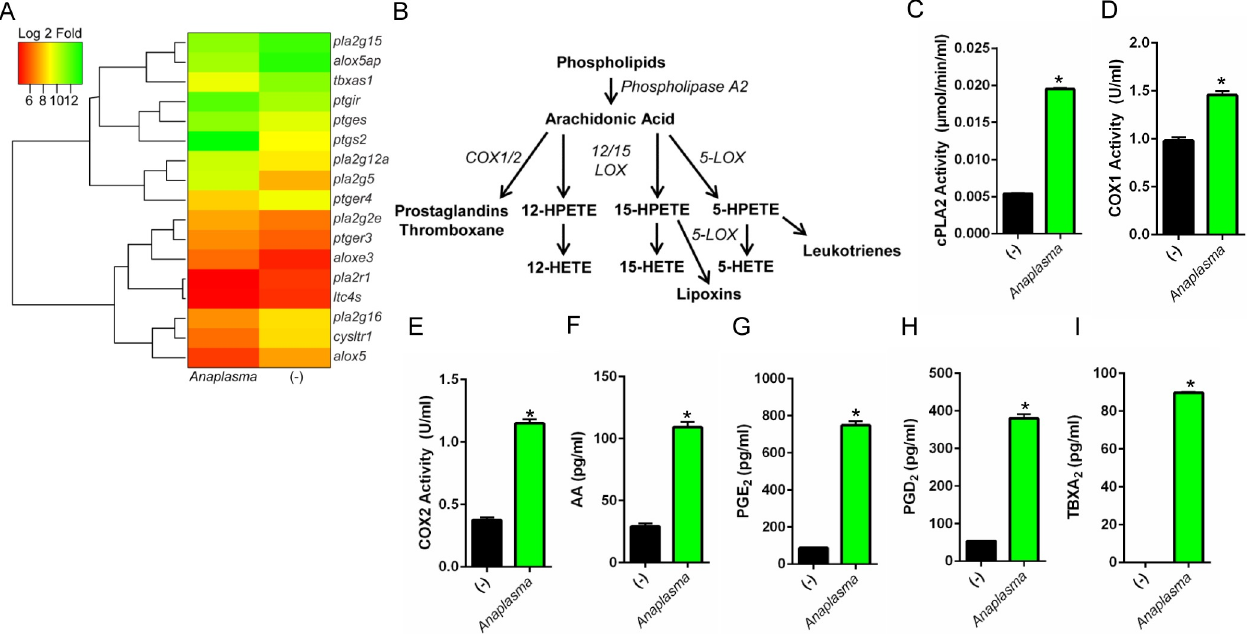
Fig 1. A. phagocytophilum infection induces eicosanoid biosynthesis. (A) Heat map of deep sequencing analysis showing the expression of eicosanoid metabolism genes in murine BMDMs (1.5×10 7 cells) infected with A . phagocytophilum (MOI50) for 18 hours. (B) Schematics of eicosanoid metabolism in murine macrophages. Eicosanoid biosynthesis occurs after the release of arachidonic acid from cell membranes by phospholipase A2 ( e . g ., cPLA 2 ). Arachidonic acid is converted to thromboxane and prostaglandins by cyclooxygenases (COX1/2), whereas 12 ‐ HETE (12 ‐ hydroxyeicosatetraenoic acid), 15 ‐ HETE, 5 ‐ HETE and leukotrienes are synthesized by lipoxygenases (12/15 ‐ LOX and 5-LOX). (C-I) 1.5×10 7 wildtype (WT) BMDMs were stimulated with A . phagocytophilum (MOI25) overnight. Cells were scraped followed by sonication. Enzymatic activities of (C) cPLA 2 , (D) COX1 and (E) COX2 were measured. Levels of (F) arachidonic acid (AA), (G) PGE 2 , (H) PGD 2 , and (I) TBXA 2 in the supernatants of WT BMDMs infected with A . phagocytophilum (MOI50) were detected. Student ’ s t test. * P < 0.05. (-) non-